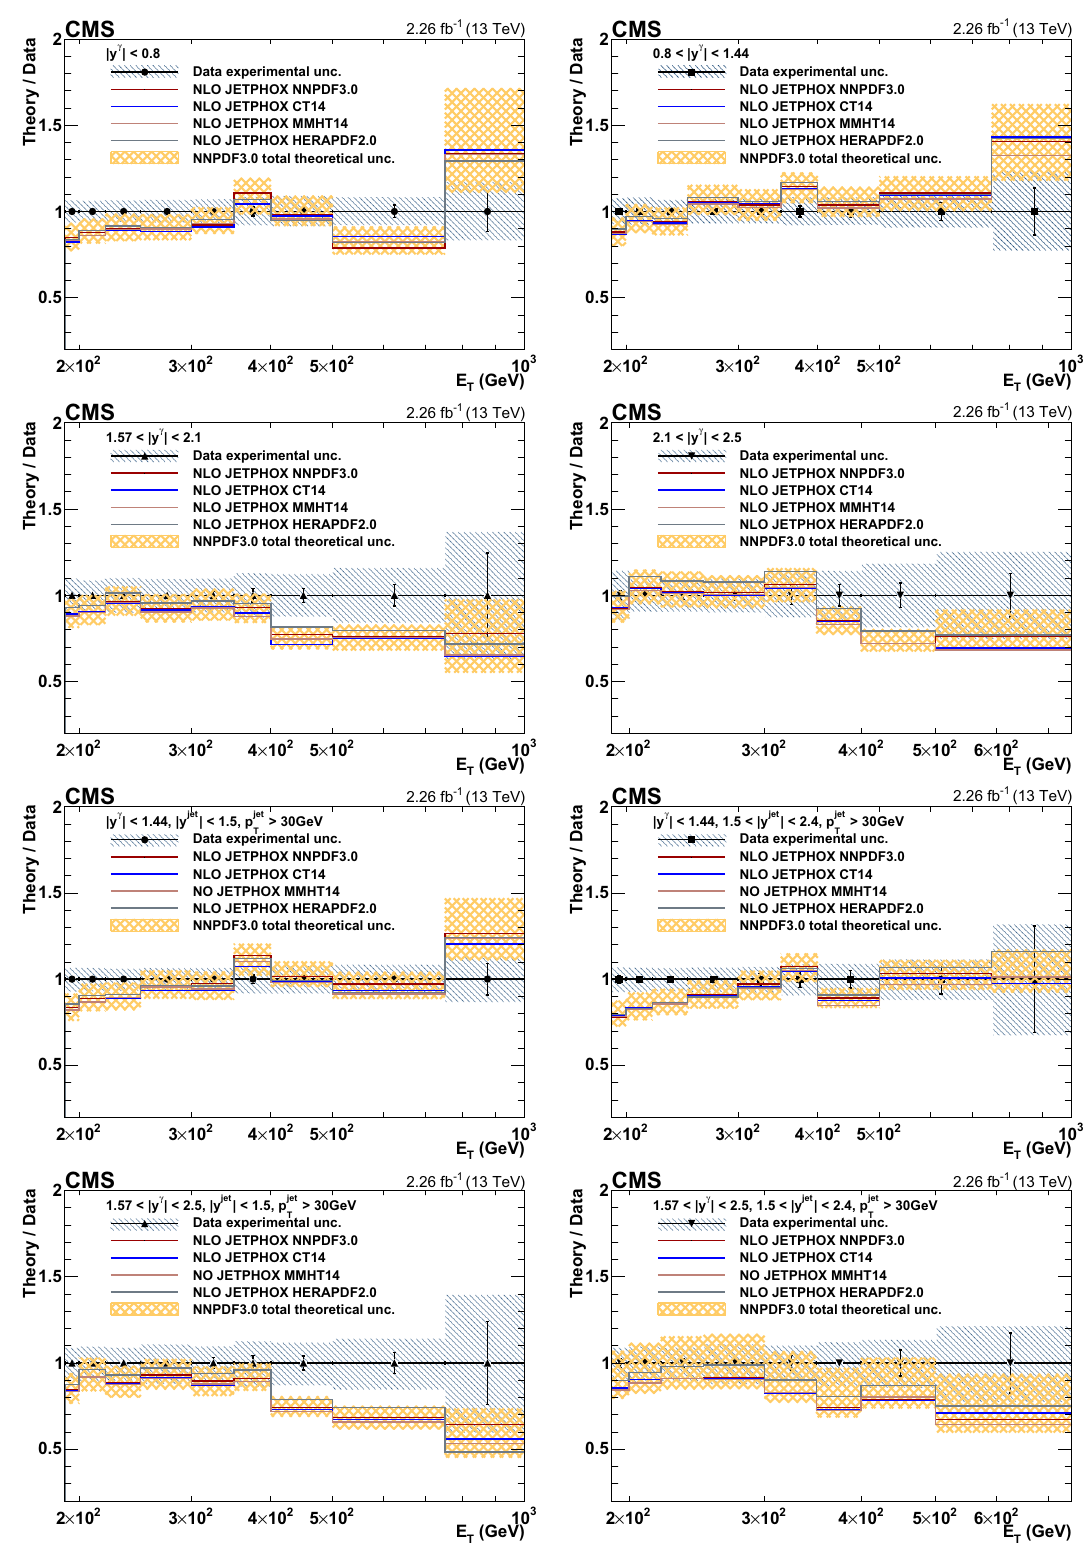
Fig. 7 Ratios of jetphox NLO predictions to data for various PDF sets as a function of photon E T for inclusive isolated-photons (top four panels) and photon+jet (four bottom panels). Data are shown as points,